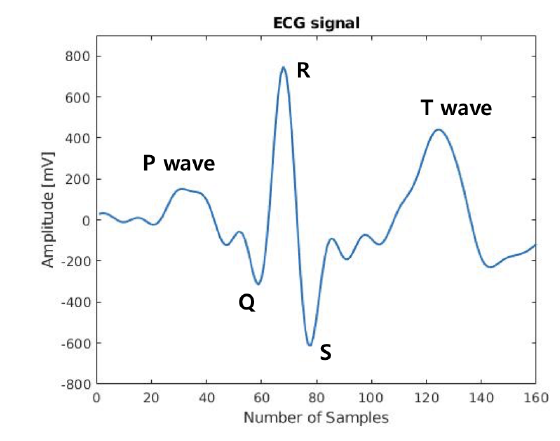
Figure 2. An Electrocardiogram (ECG) pulse measured by our in-house integrated wearable band with annotations for P-QRS